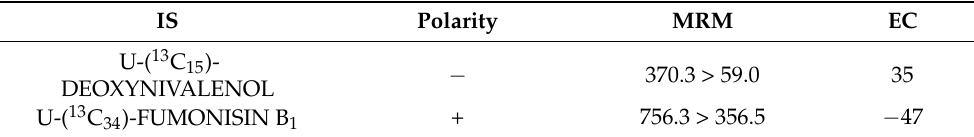
Table 1. MS/MS parameters for isotope labeled, internal standard (IS) (Romer Labs, Austria).